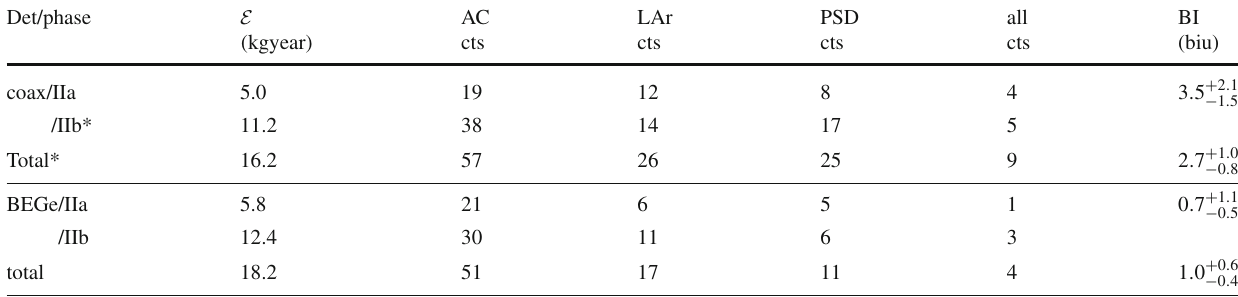
Table 13 Counts in the analysis window observed in Phase IIa and IIb with indicated exposures E after anti-coincidences within the detector array (AC), after anti-coincidences and LAr veto (LAr) or pulse shape discrimination (PSD), and after all cuts (all). The quoted background